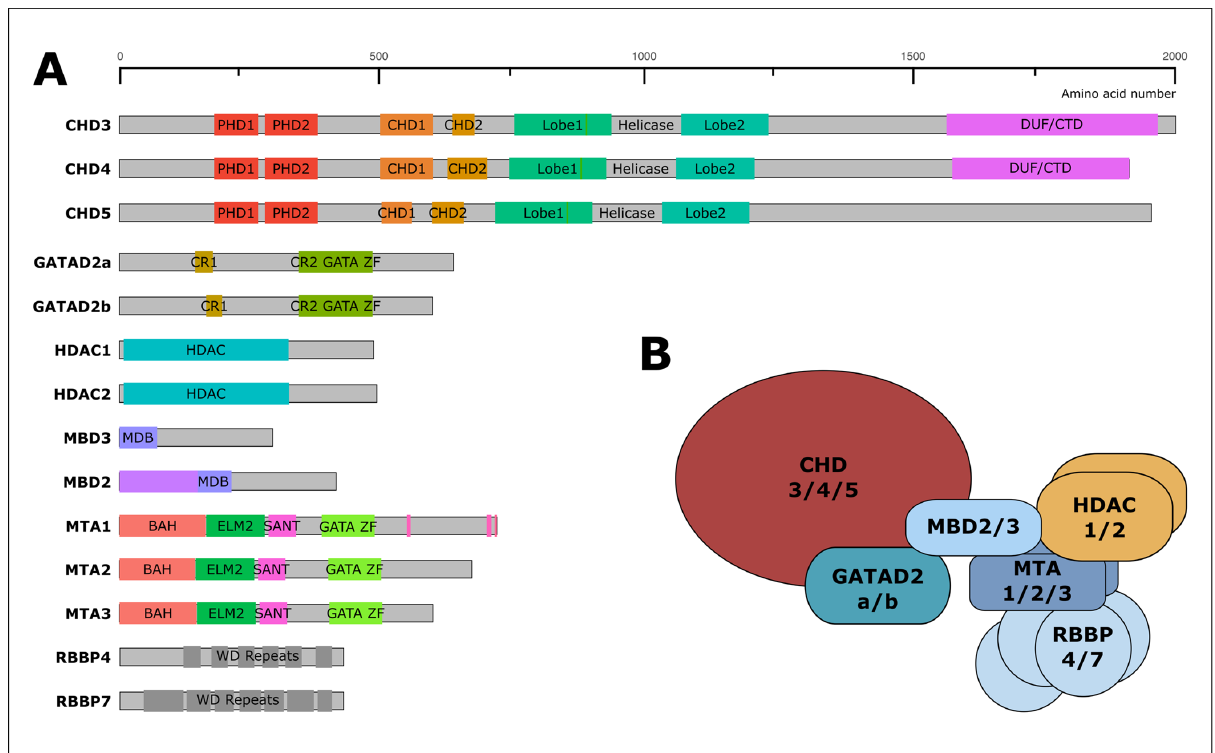
Figure 2. The NuRD complex . ( A ) Six core subunits of the NuRD complex have been identified, with each subunit being encoded by a homologous gene family. These are the chromodomain-helicase DNA-binding proteins (CHD3/CHD4/CHD5), the GATA zinc finger domain proteins (GATAD2B/GATAD2A), the histone deacetylases (HDAC1/HDAC2), the methyl-domain binding proteins (MBD2/MBD3), the metastasis-associated proteins (MTA1/MTA2/MTA3), and the retinoblastoma binding proteins (RBBP4/RBBP7). CHD and HDAC subunits confer both ATP-dependent nucleosome remodeling activity and histone deacetylase activity, respectively. Not all of the subunits are exclusive to the NuRD complex. For instance, RBBP4/7 subunits are also found in Polycomb complexes, as well as the CAF histone chaperone complex. ( B ) Proposed stoichiometry of the complex (see text for details).